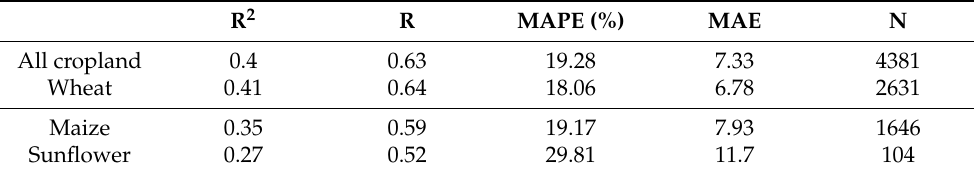
Figure 3. Scatter plot of observed vs estimated biomass productivity of total cropland area ( A ), wheat ( B ), maize ( C ) and sunflowers ( D ). Results were significant at the 0.01 level. Table 2. Test validation results of all cropland, wheat, maize and sunflowers. R 2 : correlation coefficient, R: Pearson correlation, MAPE: mean absolute percentage error, MAE: mean absolute error, N: number of